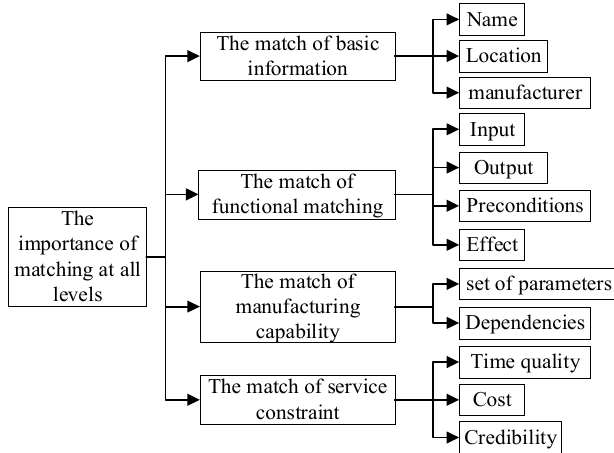
Figure 8. Schematic diagram of the hierarchical structure.